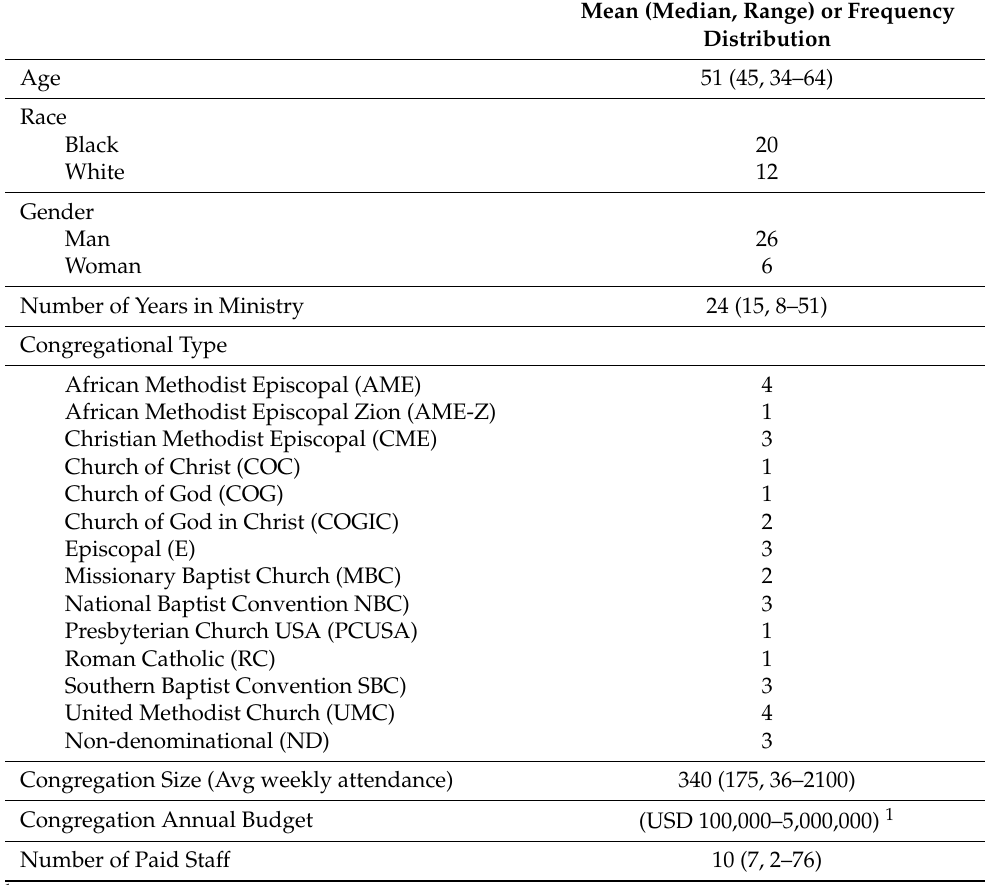
Table 1. Characteristics of participants and congregations/churches ( n =